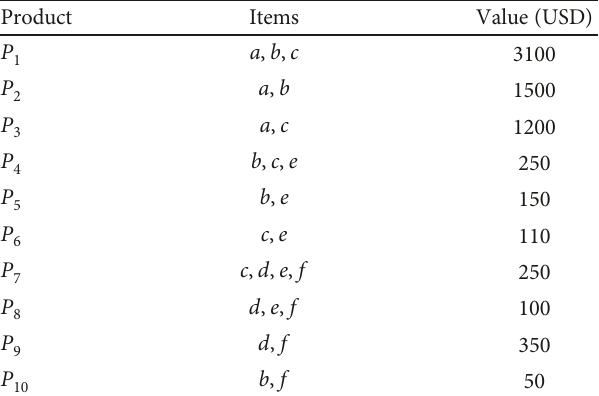
Table 1: An example of product dataset D .